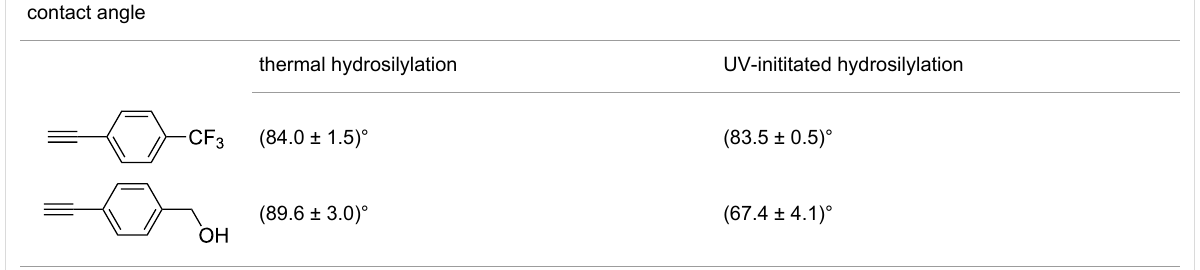
Table 1: Sessile droplet contact angle measurements of the two surfaces hydrosilylated with the two alkynes. The atomic concentration (atom %) from XPS survey spectra is also as listed below for the two different reaction mechanisms. contact angle